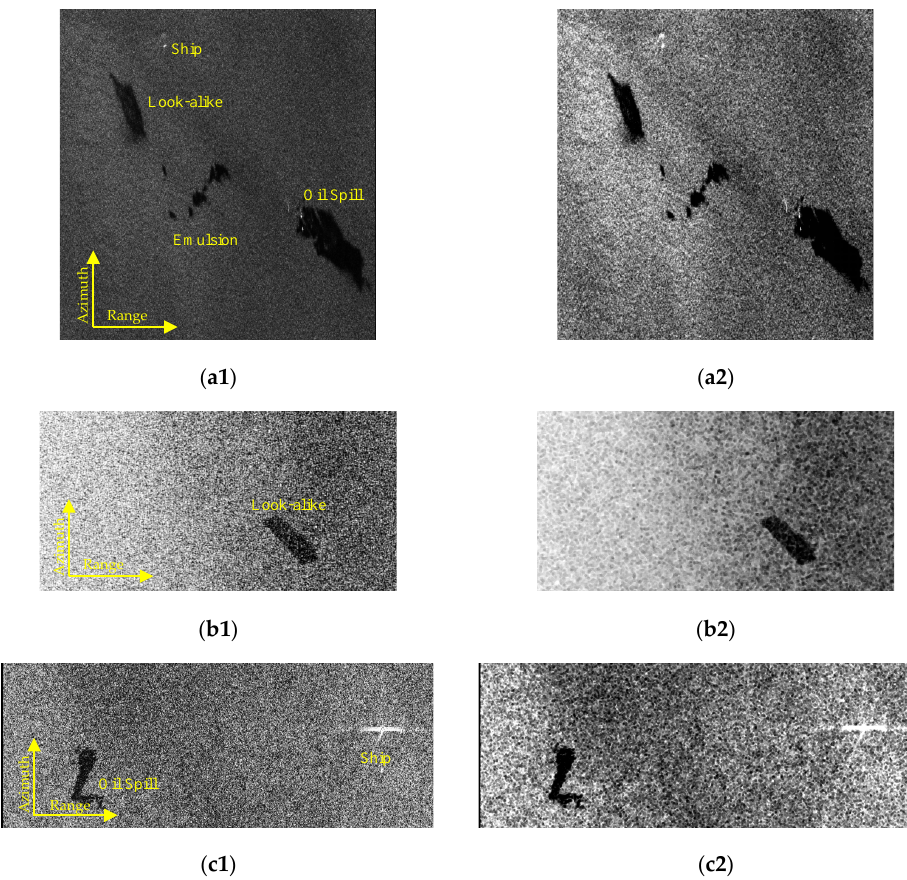
Figure 6. Three oil spill data used in the experiments. Left side shows the original image, and right side are images processed by Refined Lee Filter. ( a1 , a2 ) Image 1 acquired by Radarsat-2, ( b1 , b2 ) Image 2 (PR11588) acquired by SIR-C / X-SAR and ( c1 , c2 ) Image 3 (PR44327) acquired by Spaceborne Imaging Radar-C / X-Band Synthetic Aperture Radar (SIR-C / X-SAR).